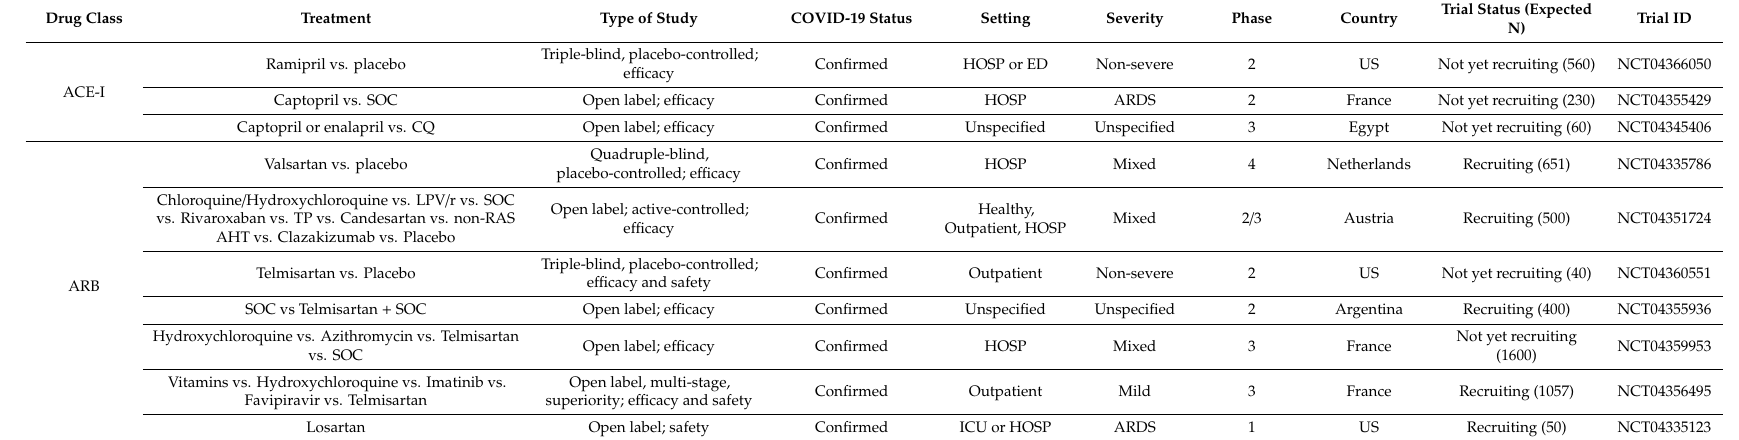
Table 2. Current or planned registered clinical trials in COVID-19 prevention and treatment investigating e ffi cacy and / or safety of RAAS